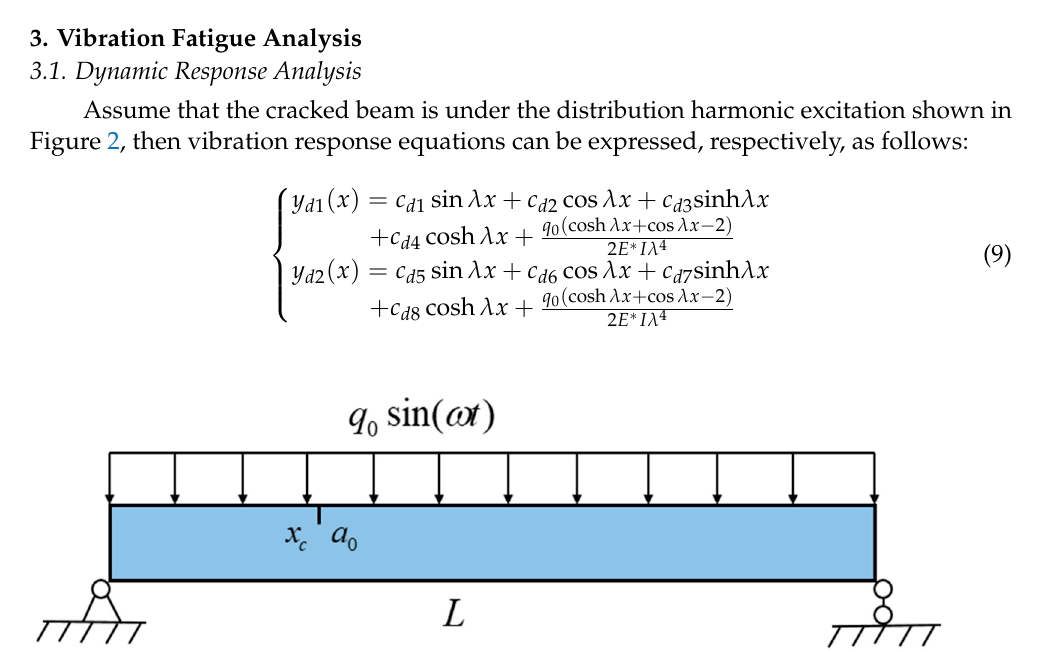
Figure 2. Model of the beam under distribution harmonic excitation.